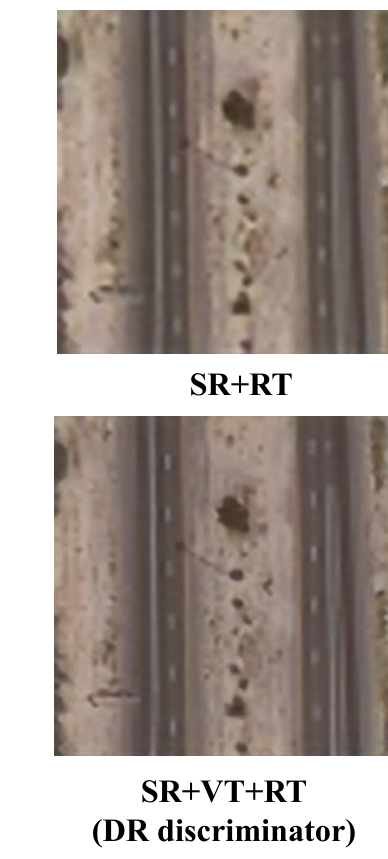
Figure 11. Visual comparison with different discriminator settings. The results are trained and tested on the UC Merced dataset with a scale of 4 ×